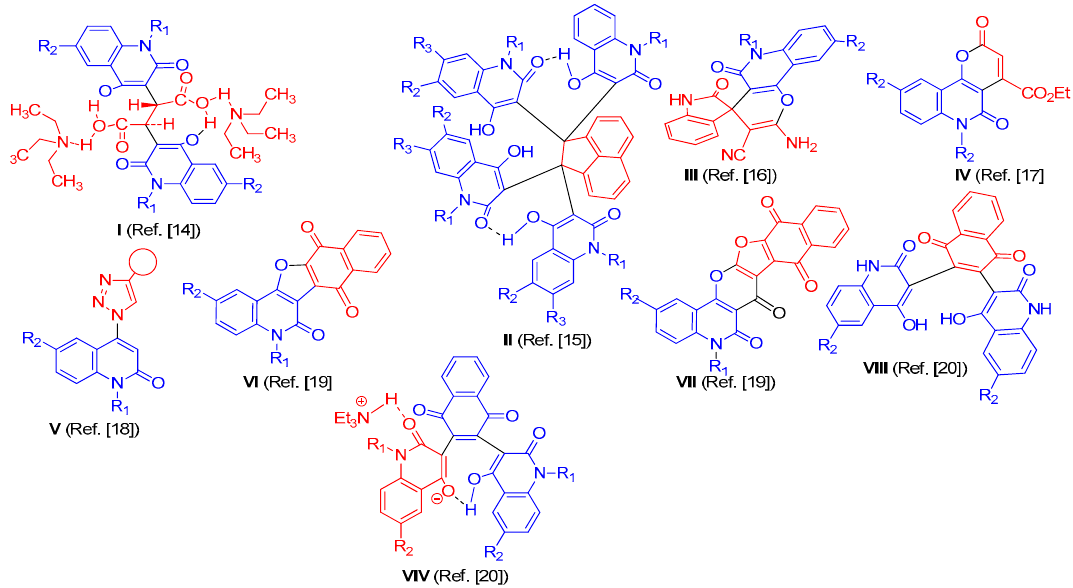
Figure 2. Structures of compounds that previously reported (Reproduced with permission from [14–20]).